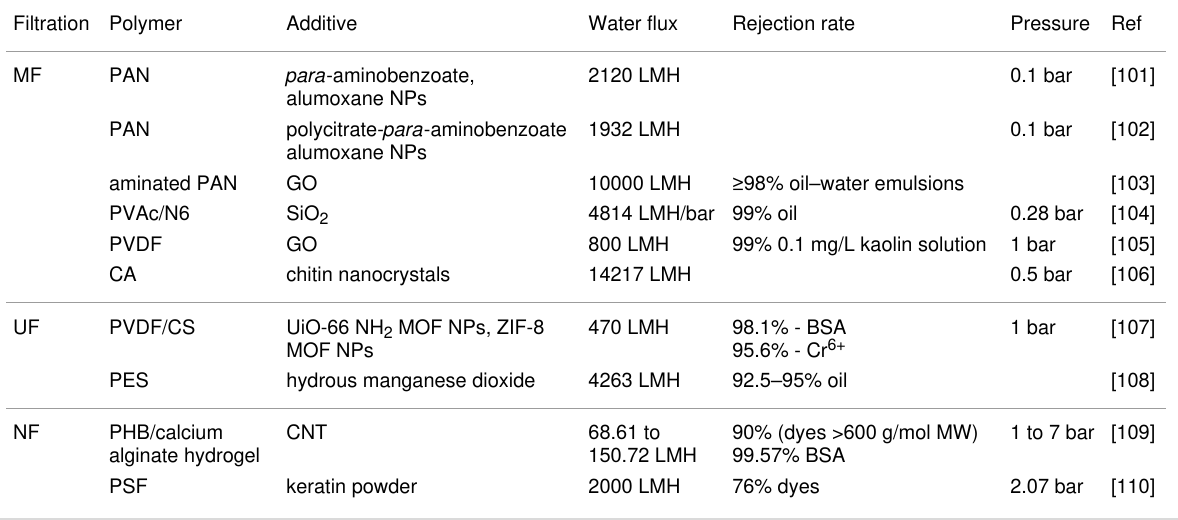
Table 2: Recently fabricated electrospun nanohybrid membranes for microfiltration, ultrafiltration, and nanofiltration. Filtration